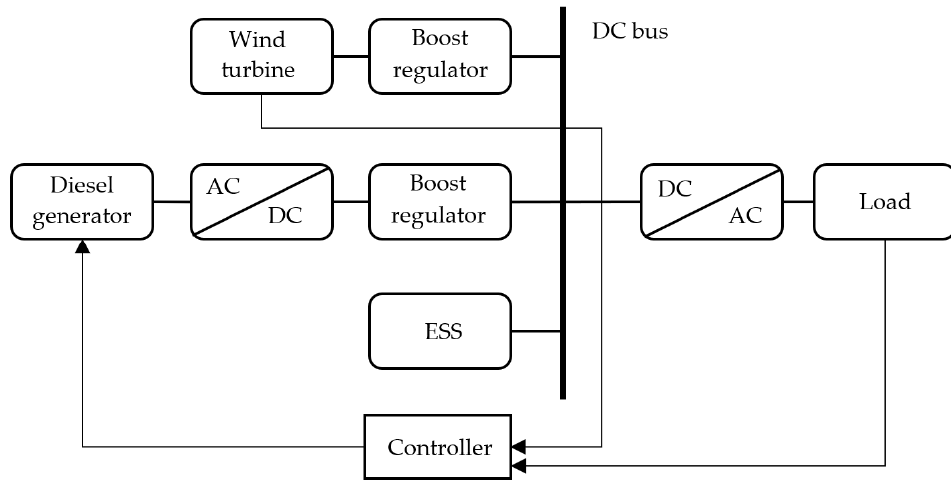
Figure 7. Variable speed WDHS. Adapted from Ref. [13].